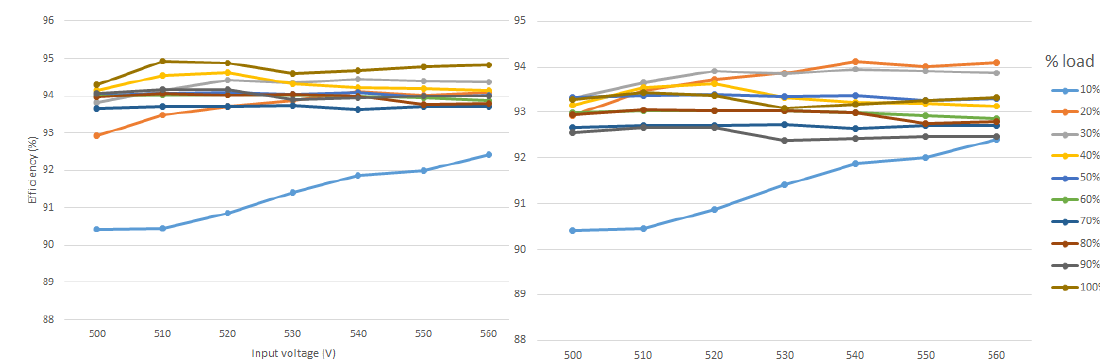
Figure 19. Measured efficiency of the prototype converter for different load values and input voltages for normal condition ( left ) and fault condition ( right